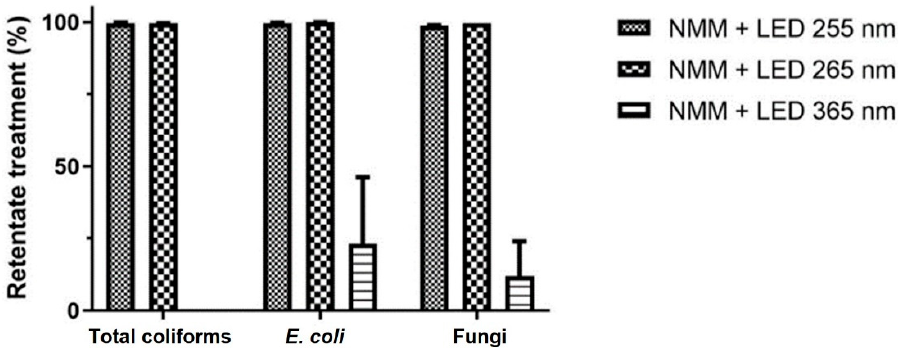
Figure 2. Retentate treatment percentage of total coliforms, E. coli and fungi after dead-end filtration of the non-modified membrane with three different LEDs (255, 265 and 365 nm) inactivation.